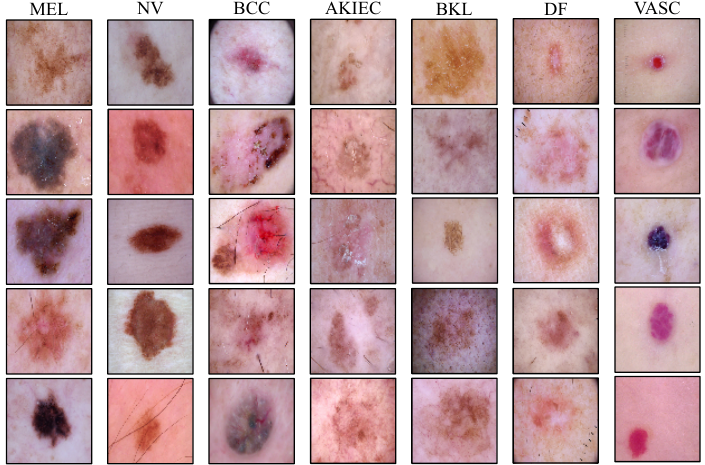
Figure 3. Illustrating examples from all of the pigmented skin lesion categories in the HAM dataset, including Melanoma (MEL), Melanocytic Nevi (NV), Basal Cell Carcinoma (BCC), Actinic Keratoses and Intraepithelial Carcinoma (AKIEC), Benign Keratosis (BKL), Dermatofibroma (DF), and Vascular lesions (VASC)